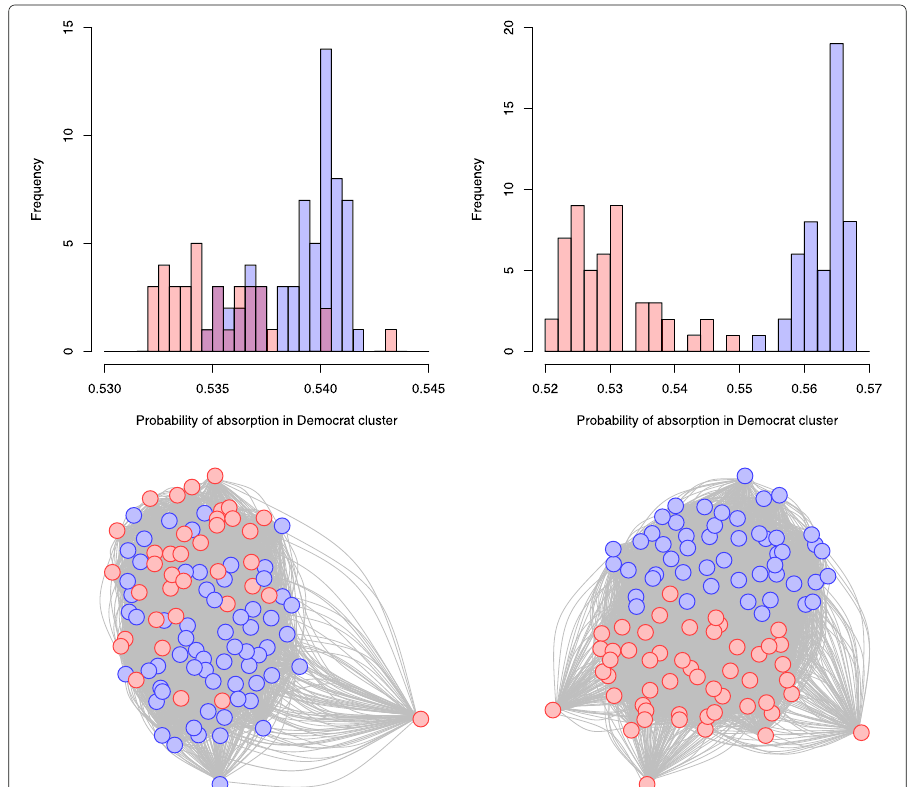
Fig. 1 Clockwise from top right: histogram of absorption probabilities for the 110 th Senate; graph of the 110 th Senate; graph of the 90 th Senate; histogram of absorption probabilities for the 90 th Senate. In the histograms, red bars represent Republican members and blue bars represent Democrat members. In the graphs, red nodes represent Republican members and blue nodes represent Democrat members. Graphs are visualised using the Fruchterman-Reingold force-directed layout algorithm. The 90 th Senate was the most difficult to correctly label using GLaSS (F1 = 0.8571). This diffculty is reflected in the overlap of red and blue bars in the histogram (top left), and interspersal of red and blue nodes in the graph (bottom left). The isolated red node on the far right of the graph corresponds to the isolated red bar on the far right of the histogram. The 110 th Senate was perfectly labelled by GLaSS (F1 score = 1), as reflected by the clear separation of red and blue bars in the histogram (top right). Also of note is the clearer separation of red and blue nodes within the graph of the 110 th Senate (bottom right), suggesting a more obvious community